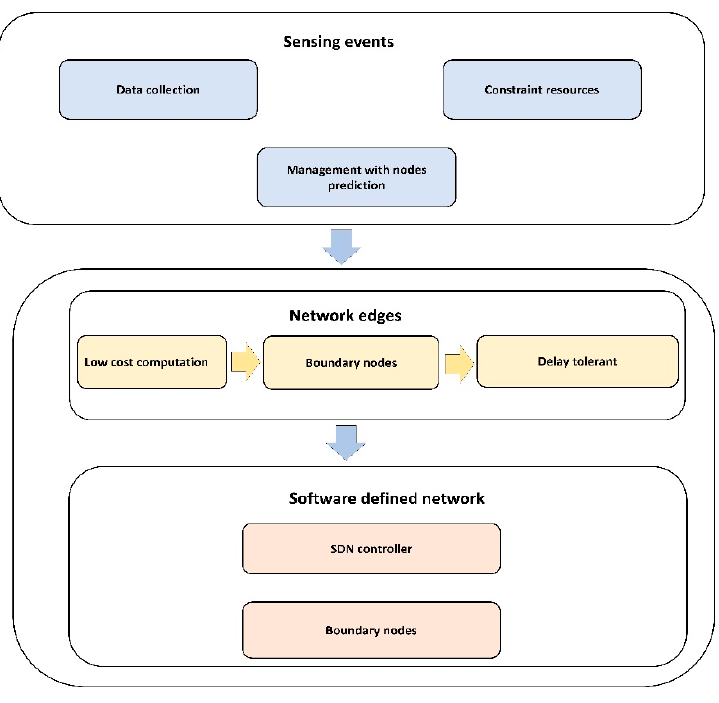
Figure 1. Block diagram of the proposed model.